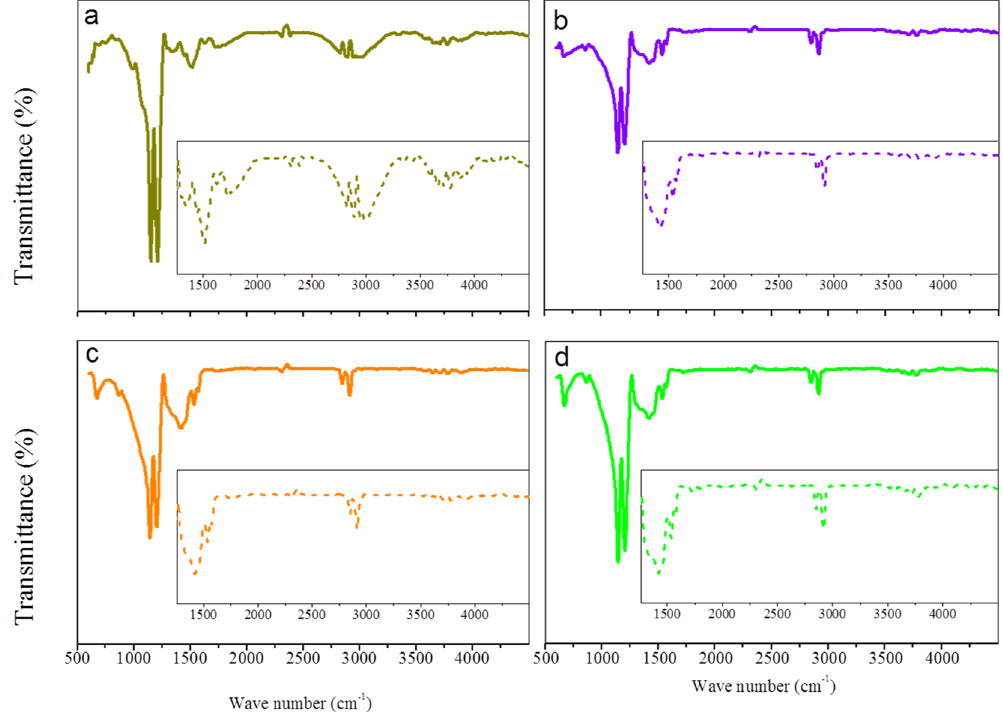
Figure 2. FT-IR profiles of CB electrodes ( a : electrode unsintered, b : electrode sintered under 100%N 2 , c : electrode sintered under